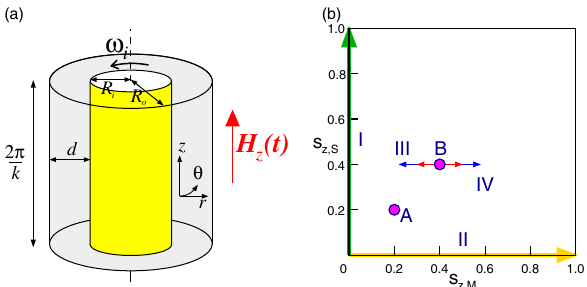
Figure 1. System and explored parameter space. ( a ) Schematic of the Taylor-Couette system (TCS) with an external applied homogeneous magnetic field H z ( t ) = [ H S + H M sin (� H t ) ] e z . ( b ) The arrows I and II indicate the investigated parameter space spanned by s z , S ∈ [ 0, 1 ] and s z , M ∈ [ 0, 1 ] . Point A gives the parameters for supercritical flow at Re = 100 . III and IV correspond to the set of parameters around the onset of stability in point B Re = 80